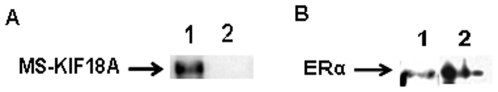
Interaction between NF-κB and MS-KIF18A or ERα.IP with anti-p50 (1) with anti-p65 (2) WB performed with anti-MS-KIF18A (A) with anti-ERα (B). Results revealed an association between MS-KIF18A and p50, but not with p65 while ERα interacts with both forms of NF-κB; p65 and p50. Results demonstrate a representative experiment of three independent repeats.